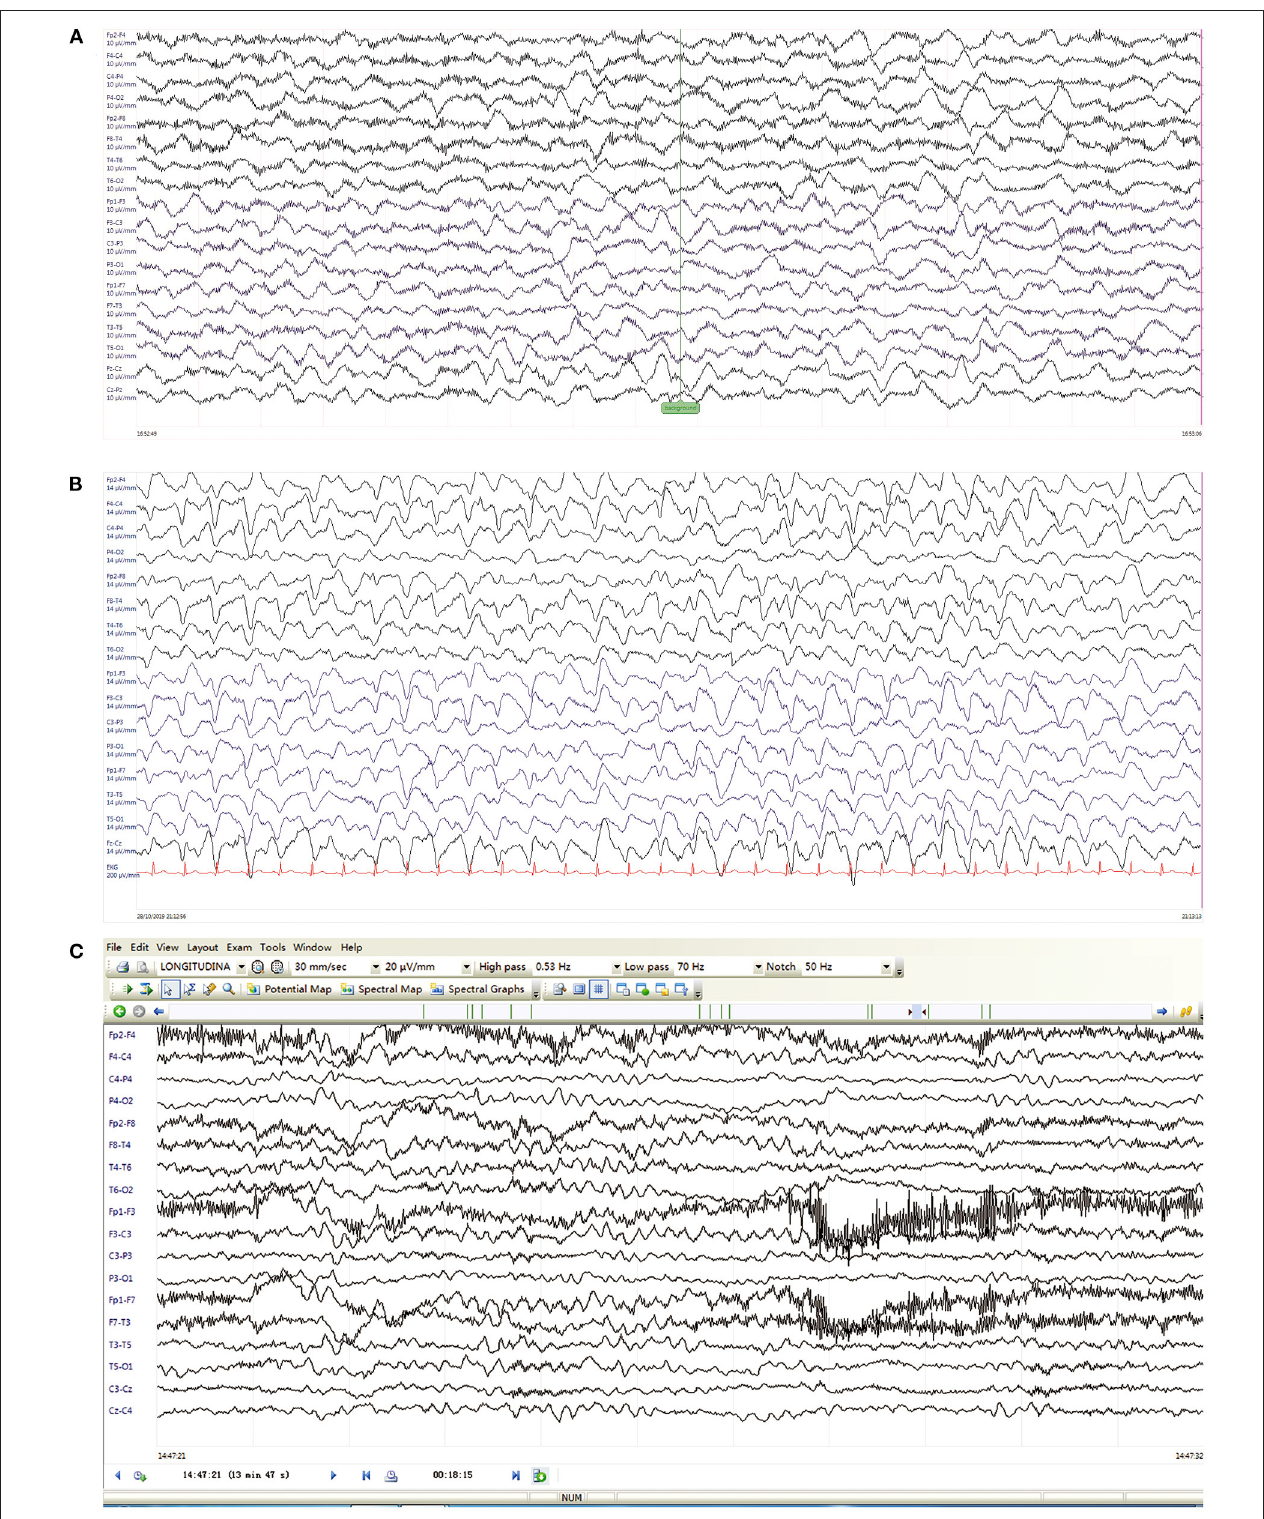
FIGURE 1 | EEG on day 2 (A) , day 8 (B) after PICU admission, and six months after inpatient discharge (C) . (A) Day 2, EEG revealed diffuse irregular slow waves. (B) Day 8, EEG showed generalized triphasic waves predominantly in frontal regions. (C) Six months later, EEG demonstrated mild slow background.